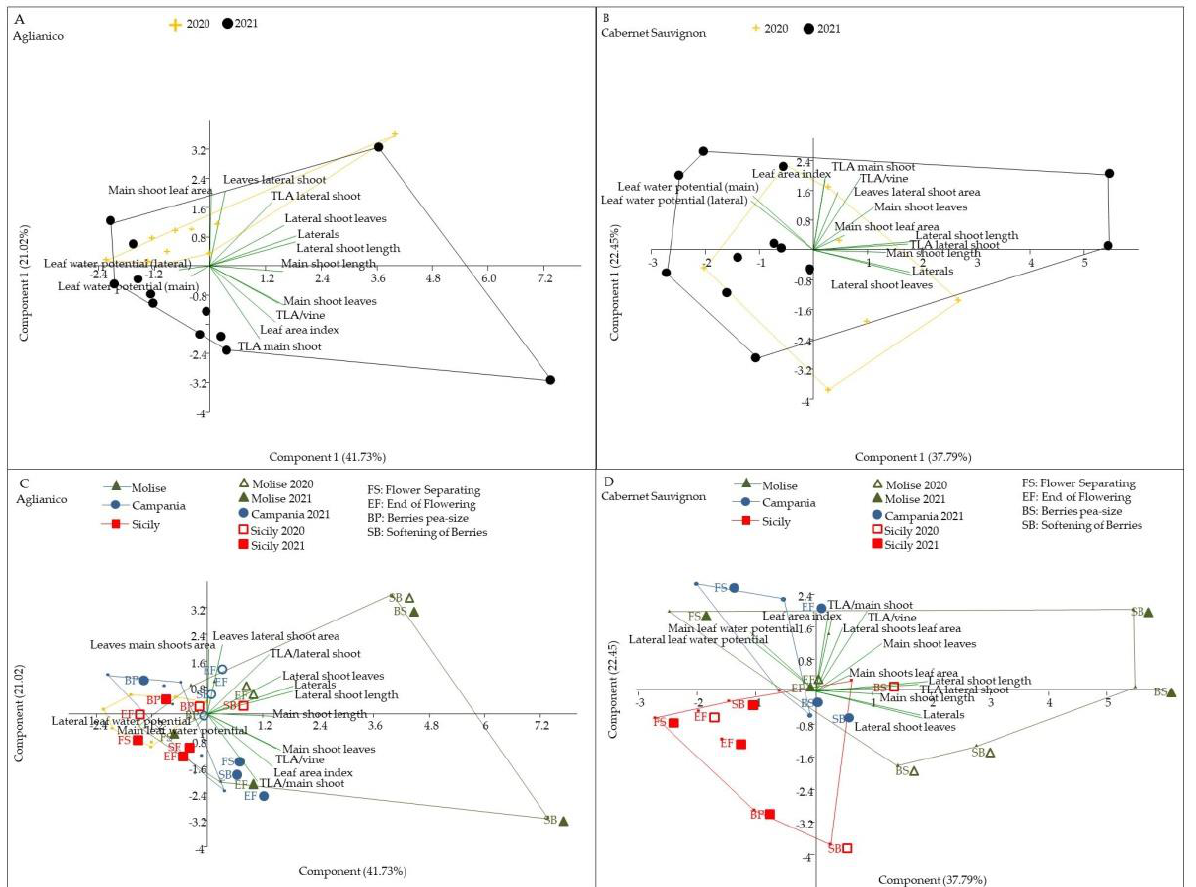
Figure 8. Biplot resulting from principal component analysis of the average data for Aglianico (AGL) and Cabernet Sauvignon (CAB), over two years (2020–2021), from three regions, Molise (MOL), Campania (CAM), and Sicily (SIC) in southern Italy, as defined by the first two principal components. The cultivars are clustered on the basis of morphological indices and midday leaf water potential at each phenological stage. The two cultivars are separated by year ( A ) for AGL and ( B ) for CAB), and by region ( C ) for Aglianico and ( D ) for Cabernet Sauvignon). Groups are delimited by convex hulls to highlight their respective